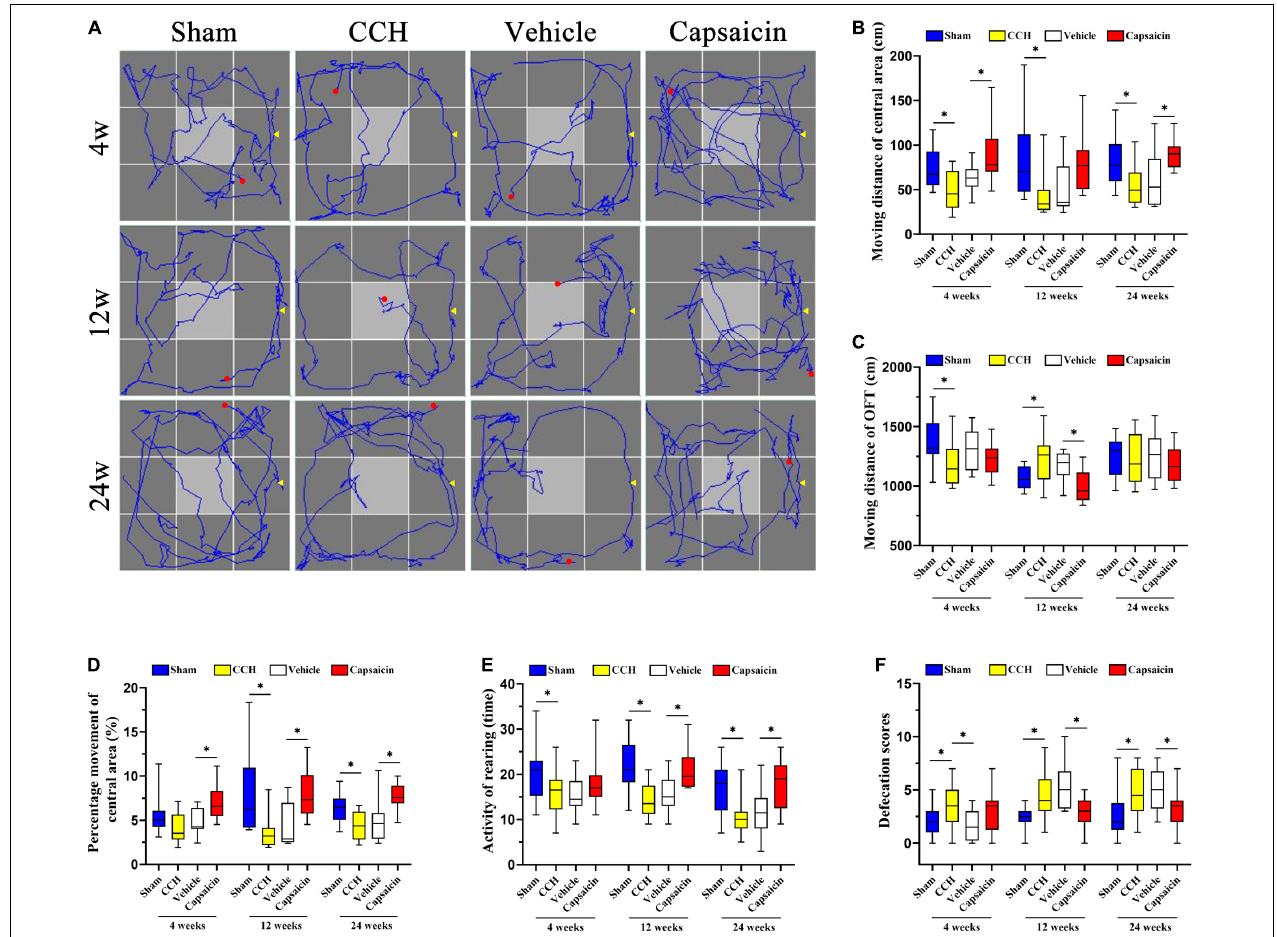
FIGURE 5 | Capsaicin relieves the changes in non-associative learning and anxiety-like behavior caused by CCH. (A) The rats’ typical performance in the OFT. (B) The distance traveled in the central area (Dc) ( n = 12). (C) The total distance (Dt) traveled in the OFT. (D) The percentage of distance traveled in the central area was higher in the sham group and capsaicin-treated group. (E) The rearing activity in the OFT. (F) Defecation scores in the OFT. Data are presented as the mean ± SD. * P < 0.05. Data were analyzed by one-way ANOVA followed by the post hoc LSD